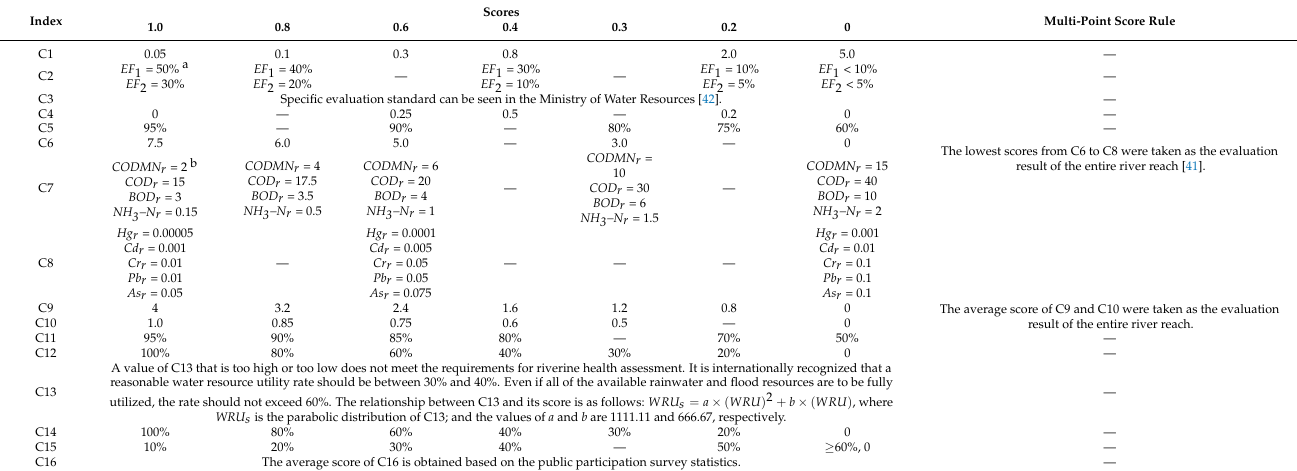
Table 2. The scoring criteria for riverine health